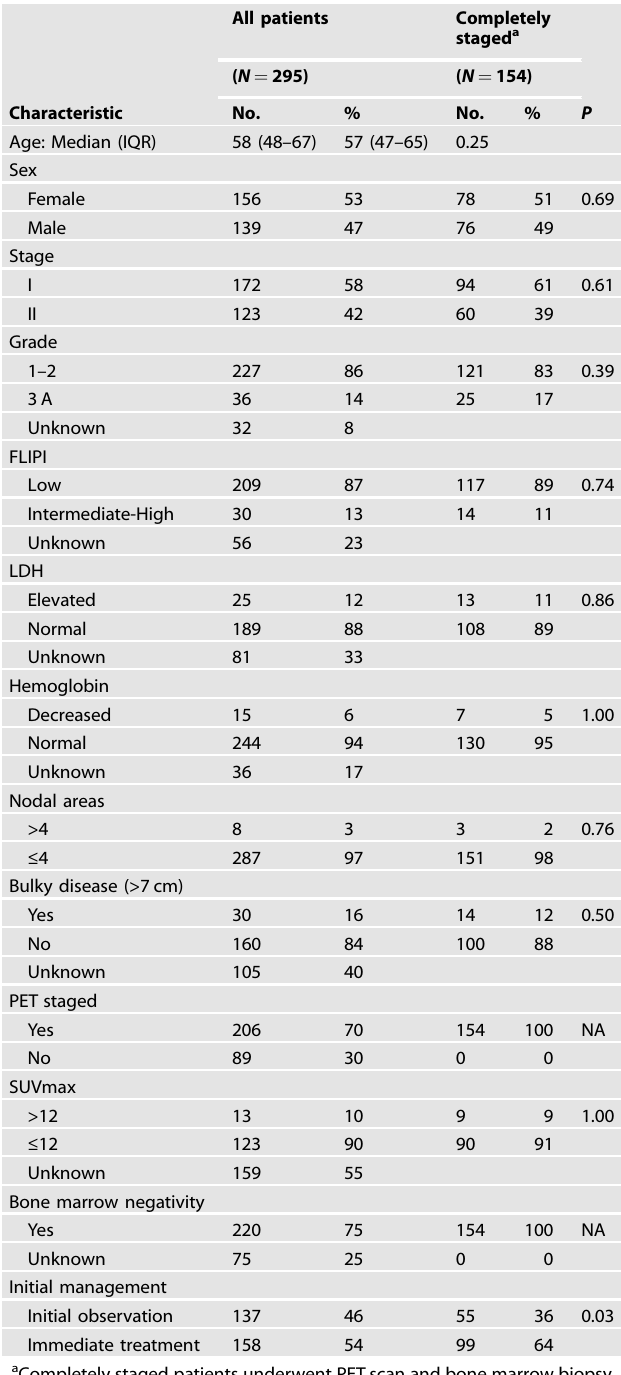
Table 1. Baseline characteristics of patients with grade 1 – 3 A, stage I – II follicular lymphoma managed at MSK between 1998 and